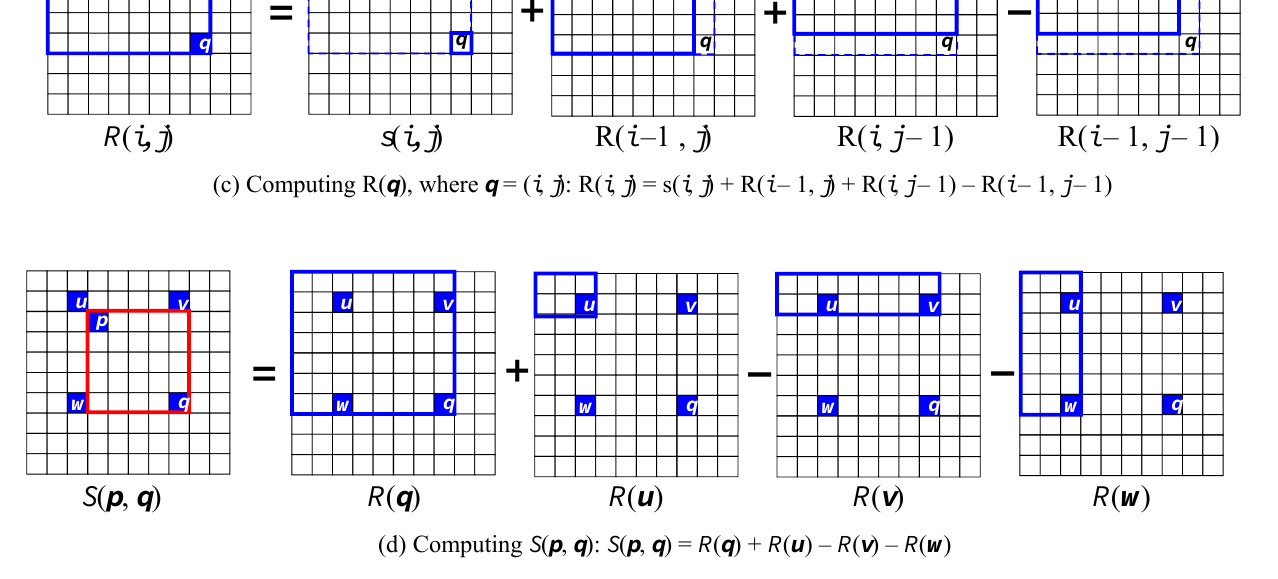
Figure 5. The process of computing auxiliary memory R and saliency score S of an image, which is motivated by cumulative sum